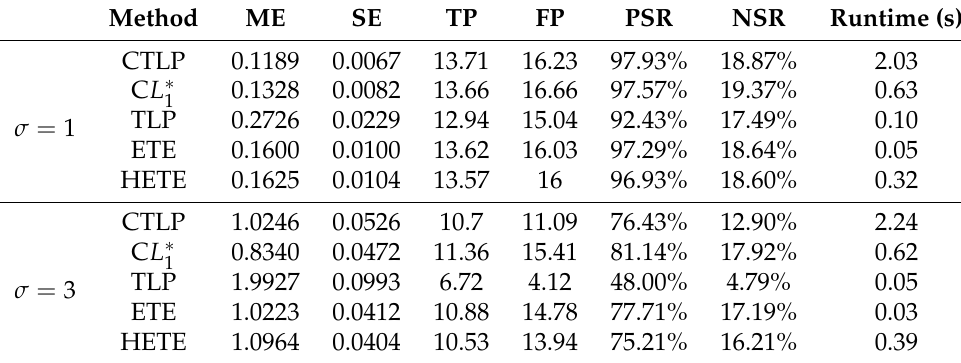
Table 7. The comparison of four methods in the case of n < p , AR ( 1 ) correlation matrix with group